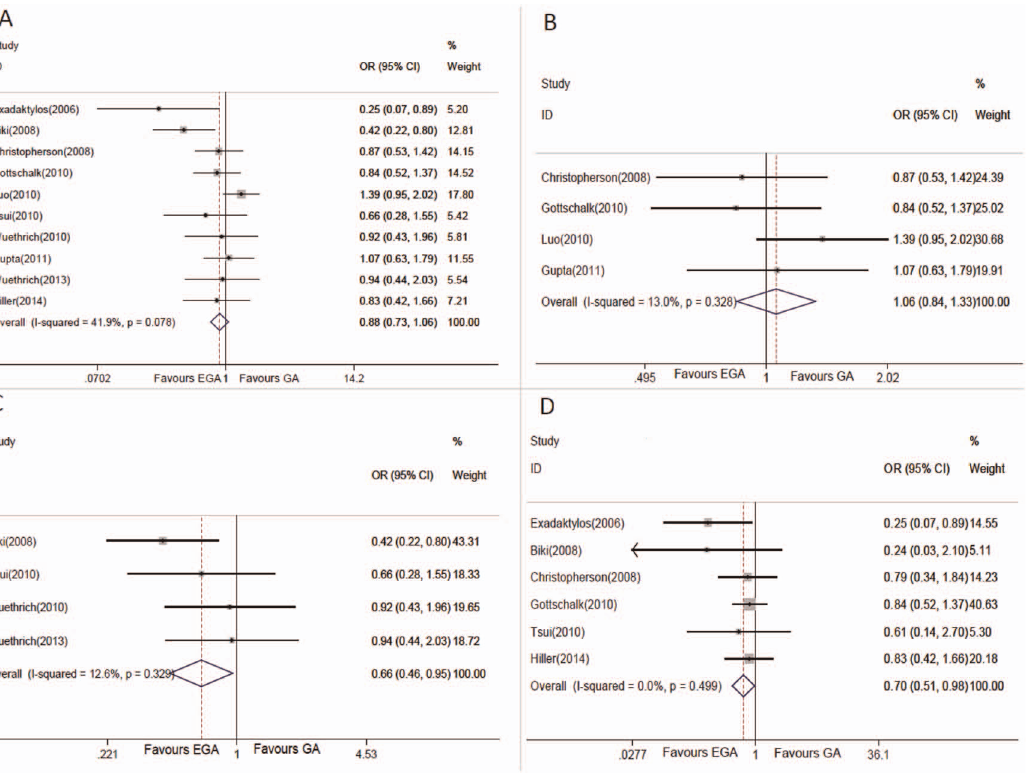
Fig. 2. Forest plots showing the association between EGA and cancer recurrence or metastasis. A. overall cancer; B. colorectal cancer; C. prostate cancer; D. cancer with follow-up less than or equal to two